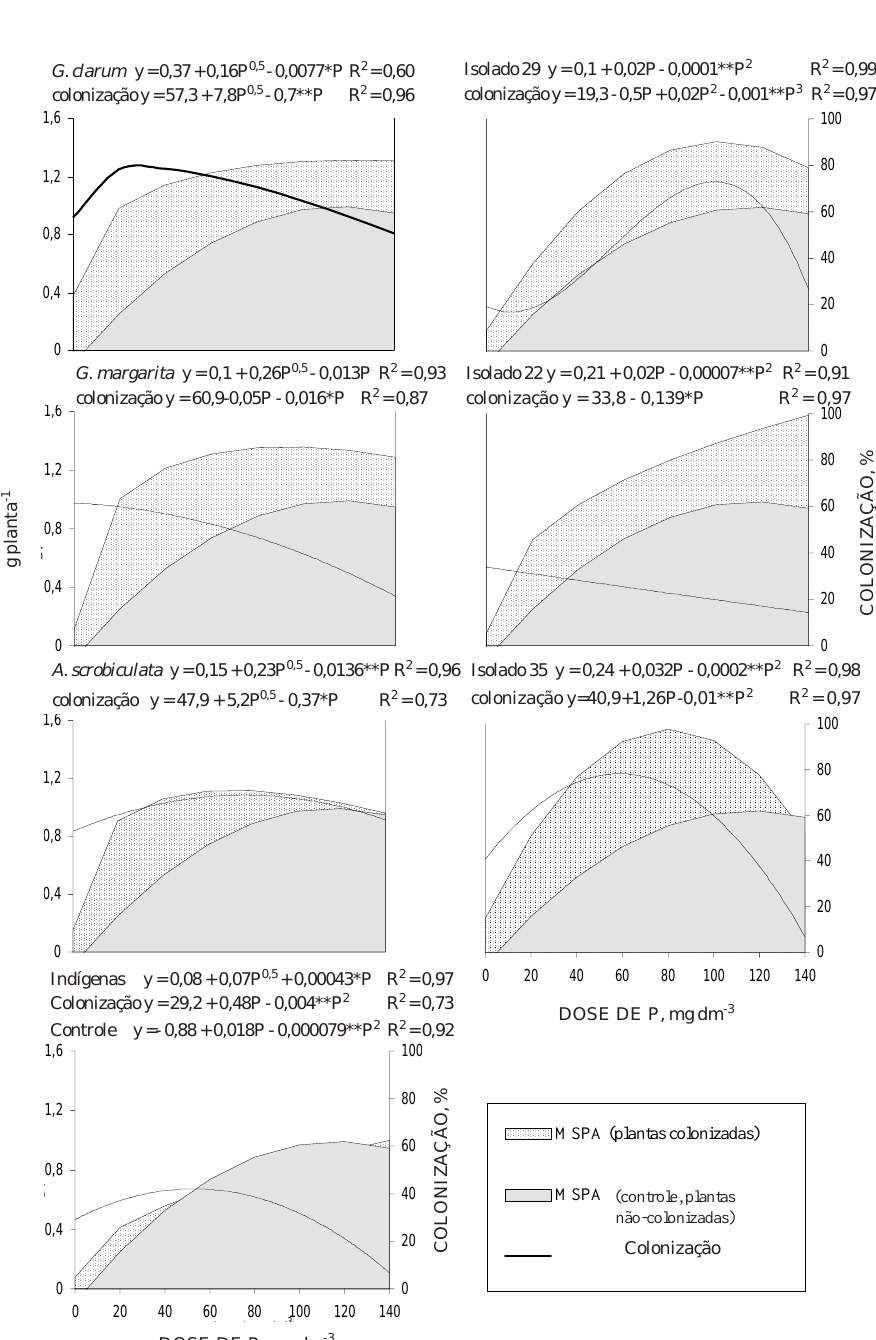
Figura 1. Matéria seca da parte aérea (MSPA) e colonização micorrízica de plantas de mamoeiro, considerando a inoculação de fungos micorrízicos arbusculares em solo não fumigado com doses crescentes de P. (* e ** Coeficientes significativos a 5 e 1%,